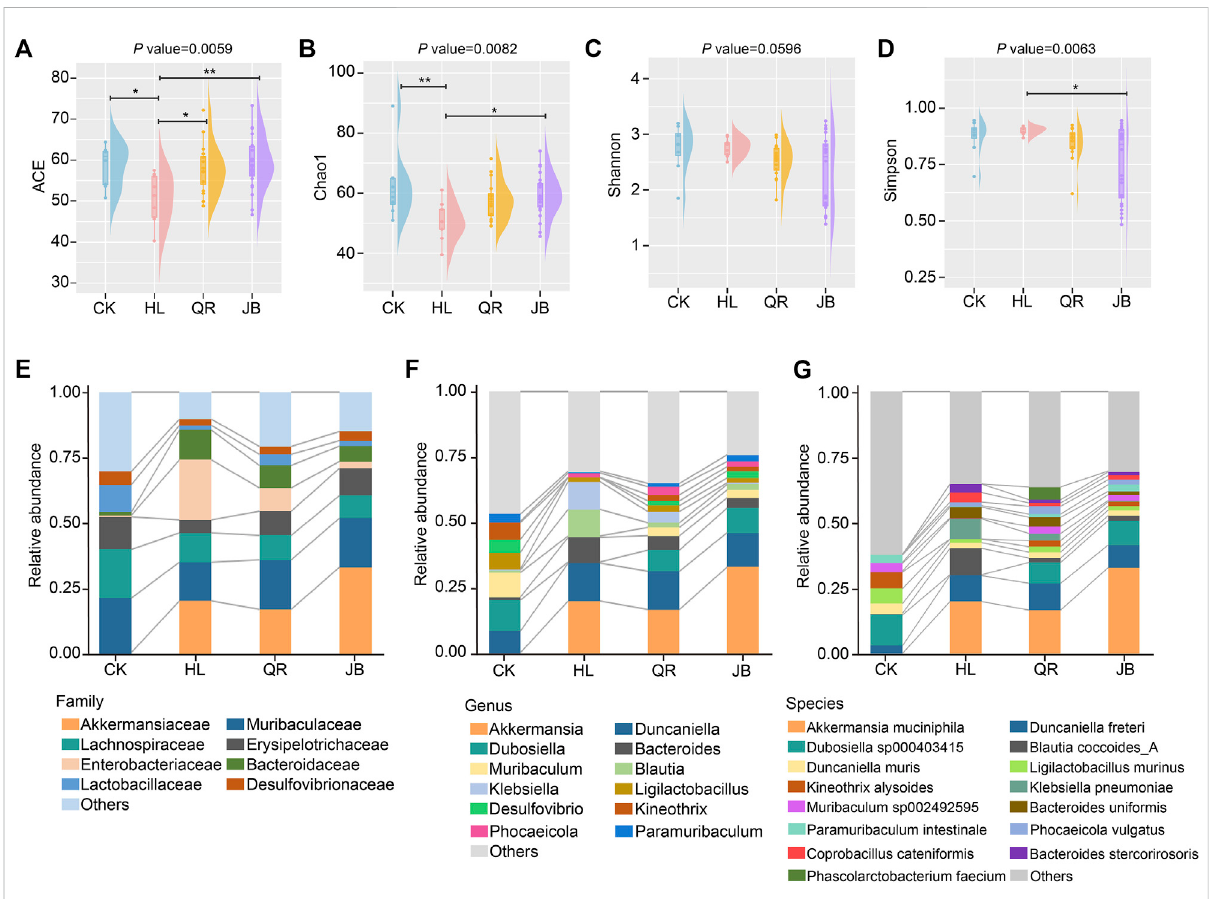
FIGURE 2 The alteration of gut microbial composition after antipyretic and diaphoretic drugs treatment. The alpha diversity of gut bacteria among four groupsassessedby (A) ACE (B) chao1, (C) shannonand (D) simpsonindices.Thegutmicrobialpro fi lediagramat (E) familylevel (F) genusleveland (G) species level. * p < 0.05, ** p <